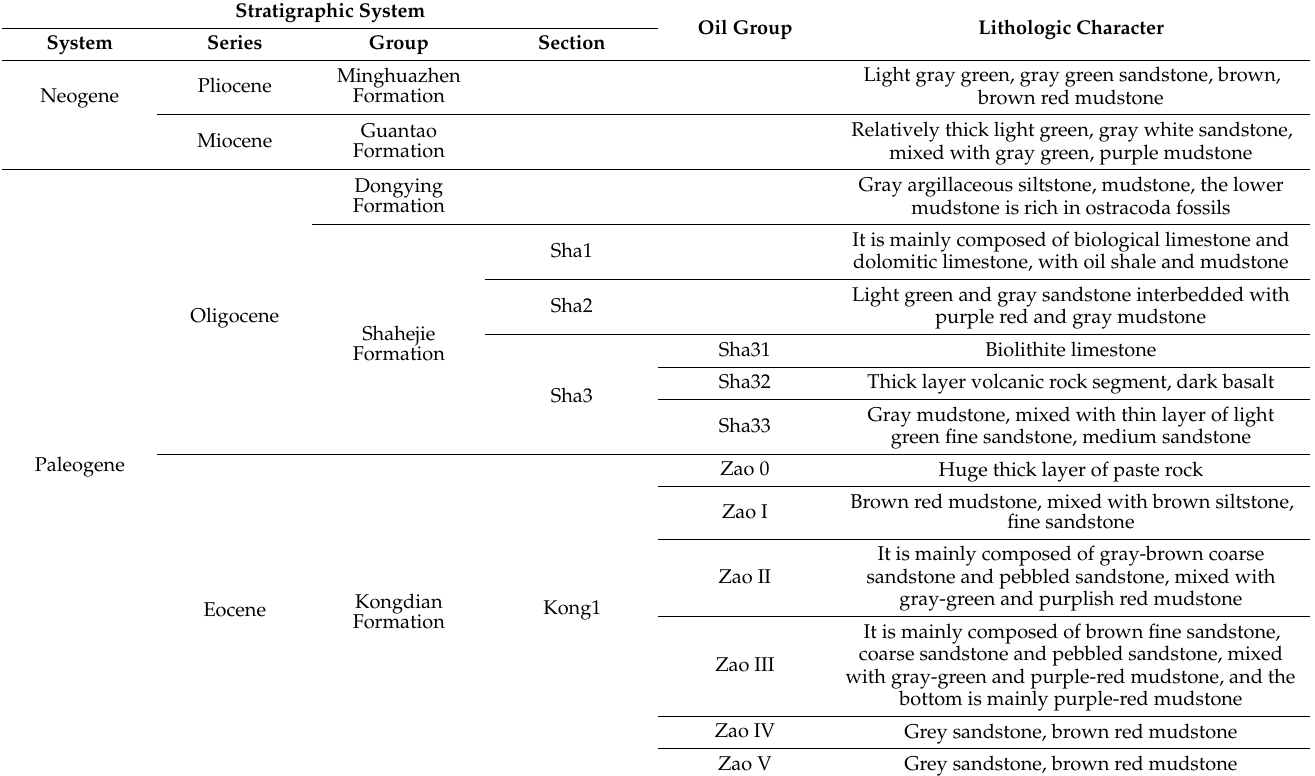
Table 1. Sedimentary characteristics of Guan187 of Wangguantun